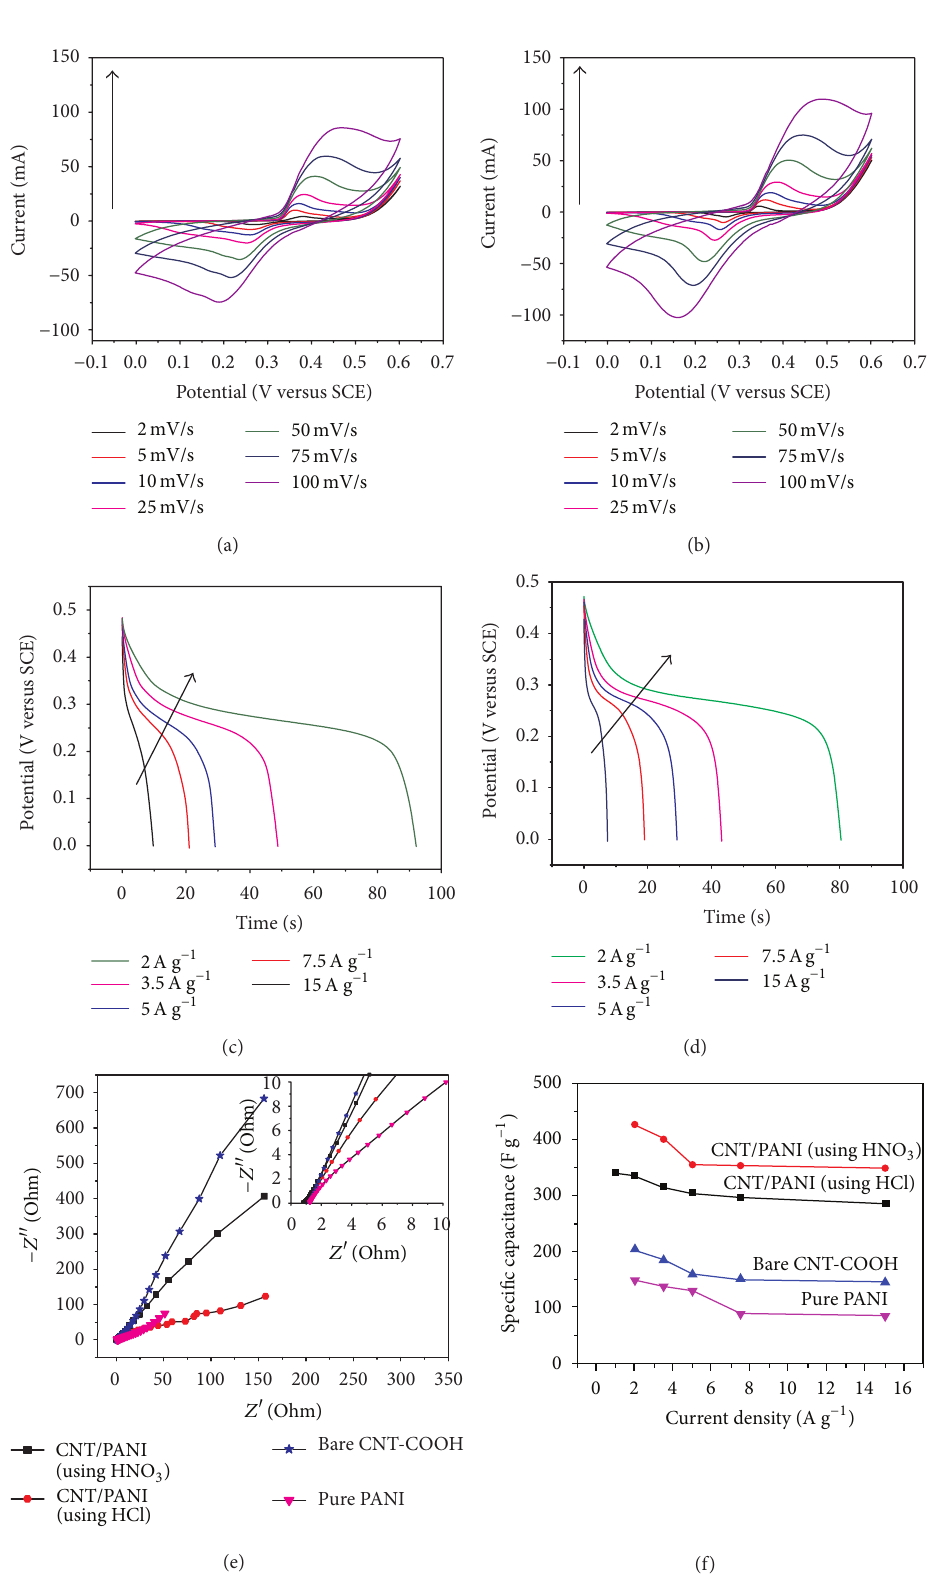
Figure 8: CV curves of the CNT/PANI composite prepared in HCl (a) and HNO 3 (b) in a 1M KOH solution at different scan rates; galvanostatic discharge curves of the CNT/PANI composites prepared in HCl (a) and HNO 3 (b) at different current densities; (e) Nyquist plots of the pure PANI, bare CNT-COOH, and CNT/PANI composites; (f) the specific capacitance of the pure PANI, bare CNT-COOH, and CNT/PANI composite electrodes at different current